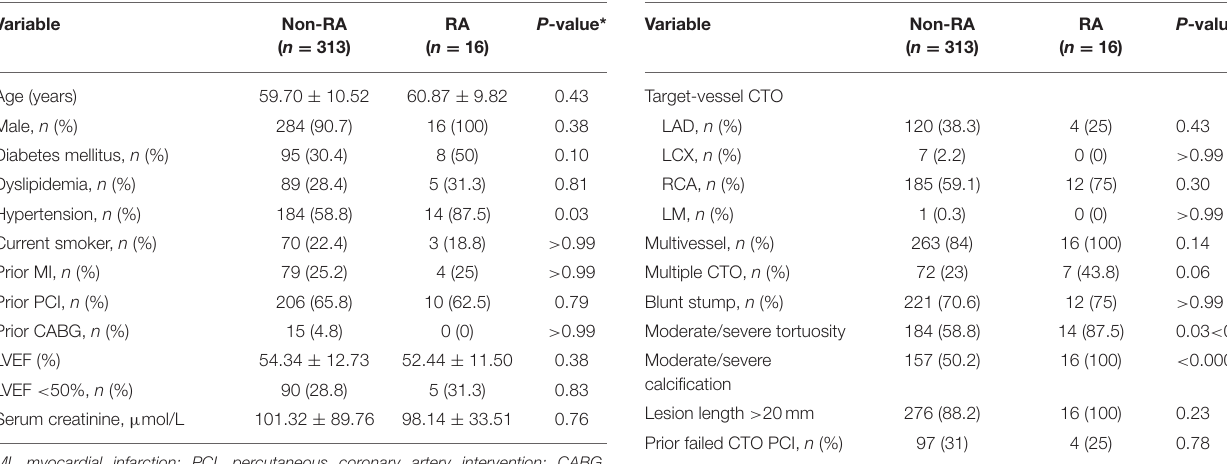
TABLE 1 | Baseline clinical